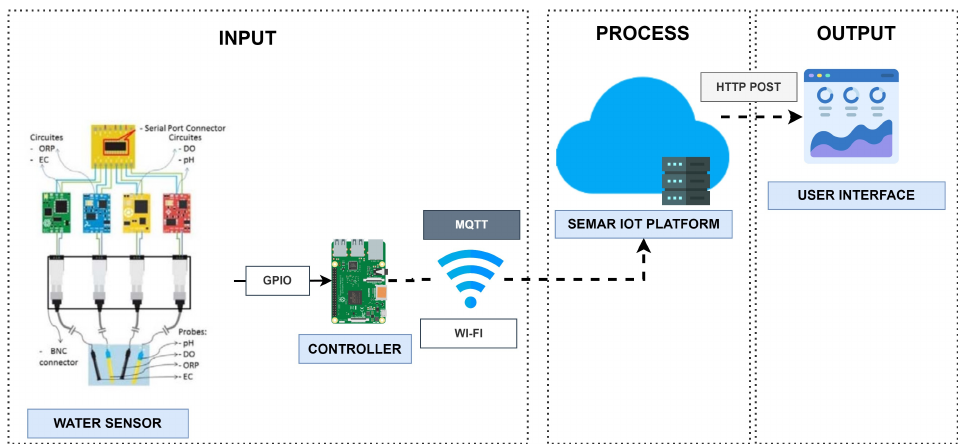
Figure 9. The system overview of the water monitoring system .